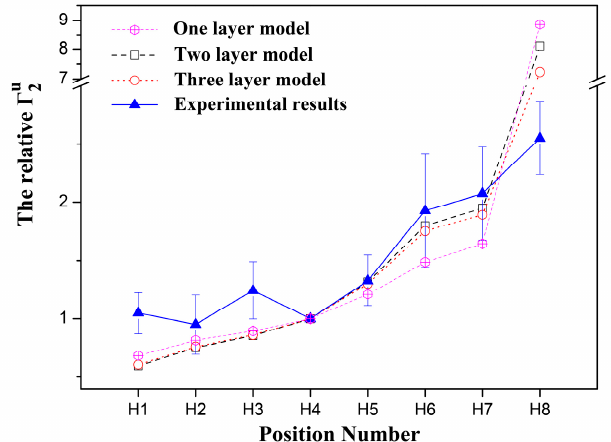
Figure 5. The relative 1 H Γ 2u of TX100 of the experimental results in comparison with calculated values for the one-, two- or three-layer aggregated pattern.